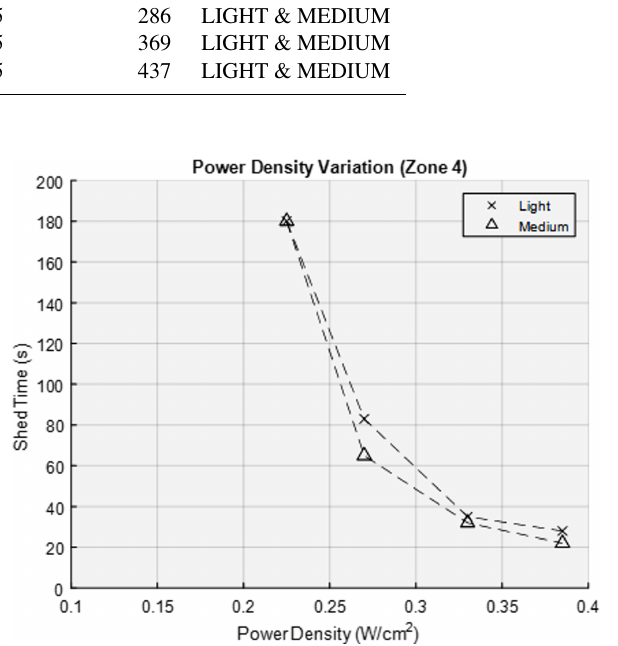
Figure 22. Melted interface between ice and airfoil leading to co- hesive bonding and failure to shed.